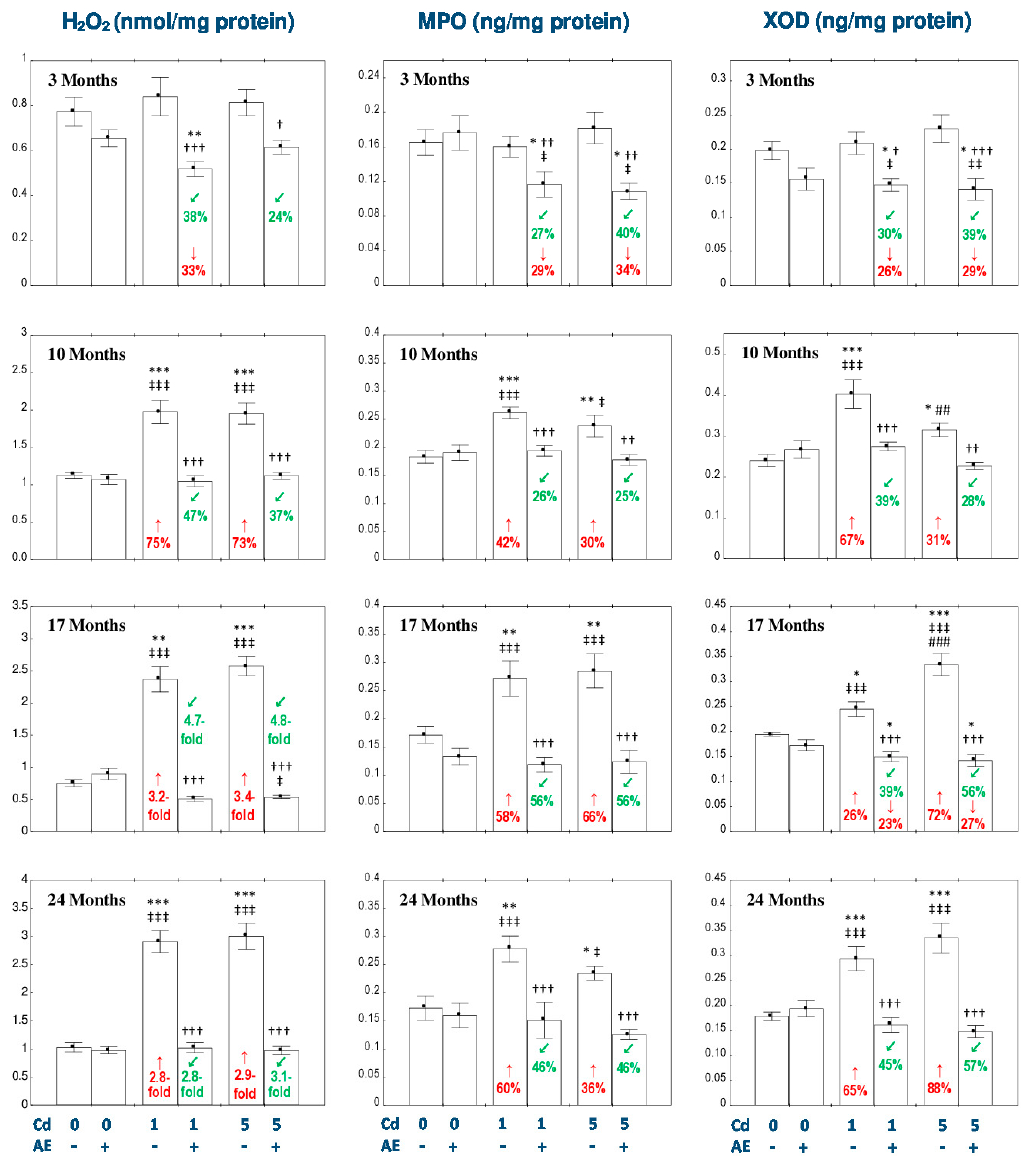
Figure 4. The effect of the extract from the berries of Aronia melanocarpa L. (AE) on the concentrations of hydrogen peroxide (H 2 O 2 ), myeloperoxidase (MPO), and xanthine oxidase (XOD) in the liver of rats exposed to cadmium (Cd). The rats received Cd in the diet at the concentration of 0, 1, and 5 mg Cd/kg and/or 0.1% aqueous AE (+) or not (-). Data are presented as mean ± SE for eight rats, except for seven animals in the AE, Cd 1 , and Cd 5 group after 24 months. Statistically significant differences (ANOVA, Duncan’s multiple range test): * p < 0.05, ** p < 0.01, *** p < 0.001 vs. control group; † p < 0.05, †† p < 0.01, ††† p < 0.001 vs. respective group intoxicated with Cd alone; ‡ p < 0.05, ‡‡ p < 0.01, ‡‡‡ p < 0.001 vs. group receiving AE alone; ## p < 0.01, ### p < 0.001 vs. respective group receiving the 1 mg Cd/kg diet (alone or with AE). Numerical values in bars or above the bars disclose the percentage changes or factors of changes in comparison to the control group ( ↓ , decrease; ↑ , increase) or the respective group receiving Cd alone ( ↙ , decrease).